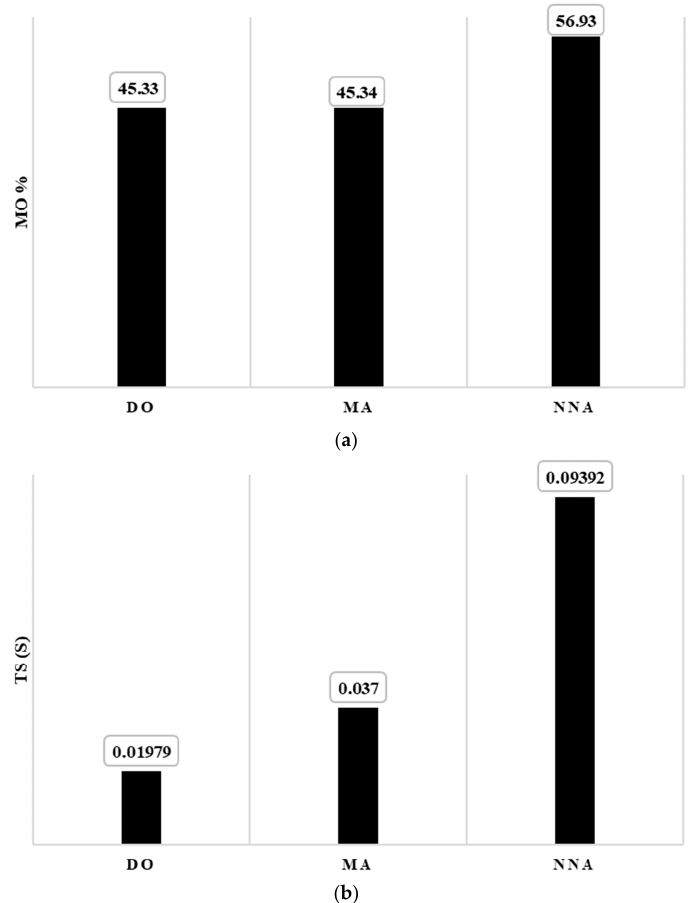
Figure 9. The performance damping indexes due to each technique ( a ) the response overshoot “ M o ”, ( b ) the response settling time “ t s ”.